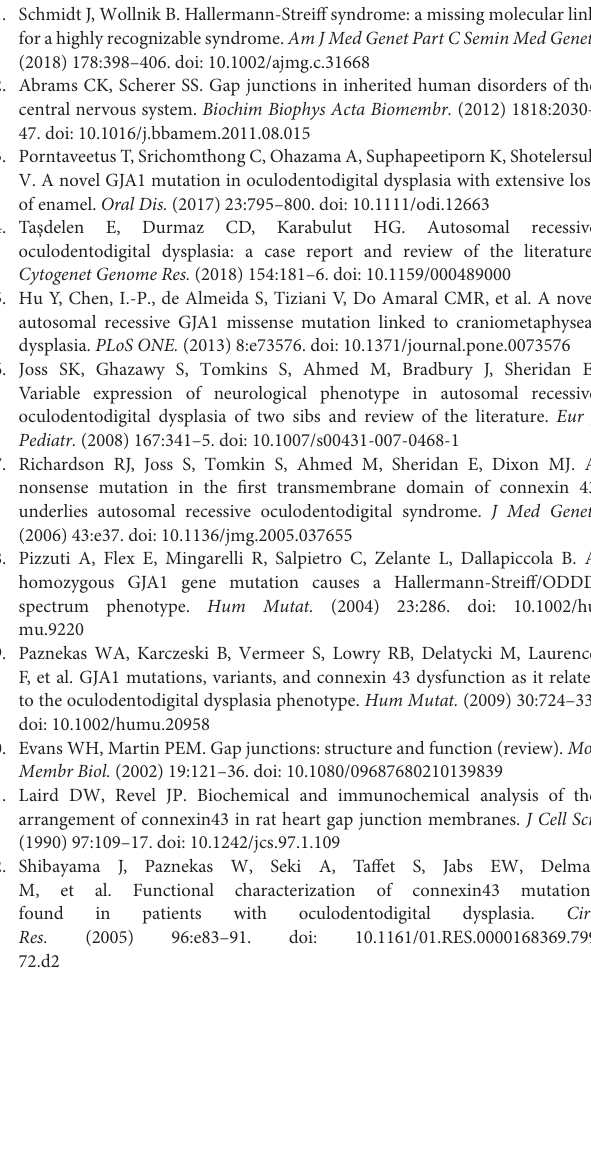
Supplementary Table 2 | Homozygous, compound heterozygous and de novo variants after filtration.